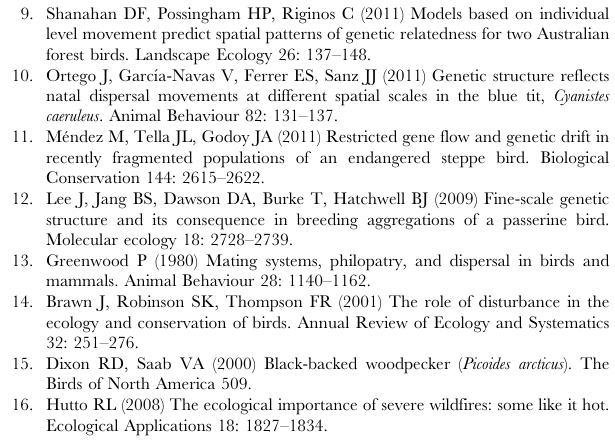
Figure S1 A map of the United States and Canada showing the hierarchical sampling design including (a) the location of the seven broad-scale study sites: AB: Jasper National Park, Alberta; MSLA: Missoula, Mon- tana; GL: Glacier National Park, Montana; OR: Silver Lake, Oregon; EC: Eastern Canada, Que´bec Grands Jardins Park; SD: Black Hills, South Dakota; ID: central Idaho; and (b) the two study sites within western Montana that each have three areas that burned in 2003: Missoula – BLM: Black Mountain fire; BM: Boles Meadow fire; FC: Fish Creek fire and Glacier National Park – WC: Wedge Canyon fire; RB: Robert fire; TR: Trapper fire. (TIF) Table S1 Results from a one-tailed test for positive genetic autocorrelation ( r ), which is expected when there is limited dispersal, for both sexes, then for males and females separately. The number of pairwise comparisons (N) per distance class (km), estimated genetic correlation for each distance class (r), and the probability the estimated r is greater than expected based on 1000 permutations (P); significant values are indicated in